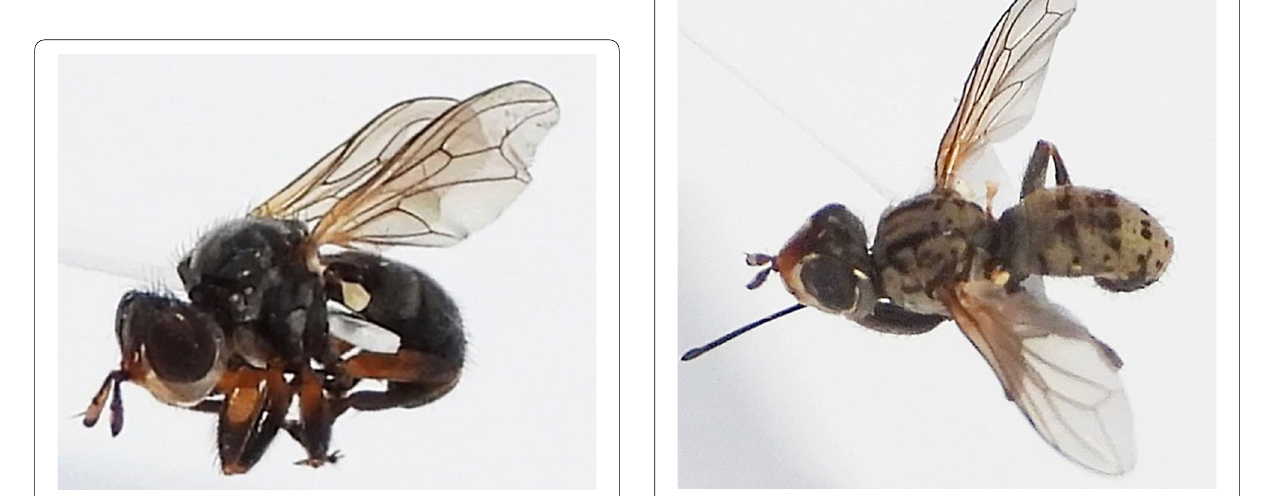
Fig. 5 Thecophora atra (Fabricius) male, lateral Fig. 6 Zodion cinereum (Fabricius) male,